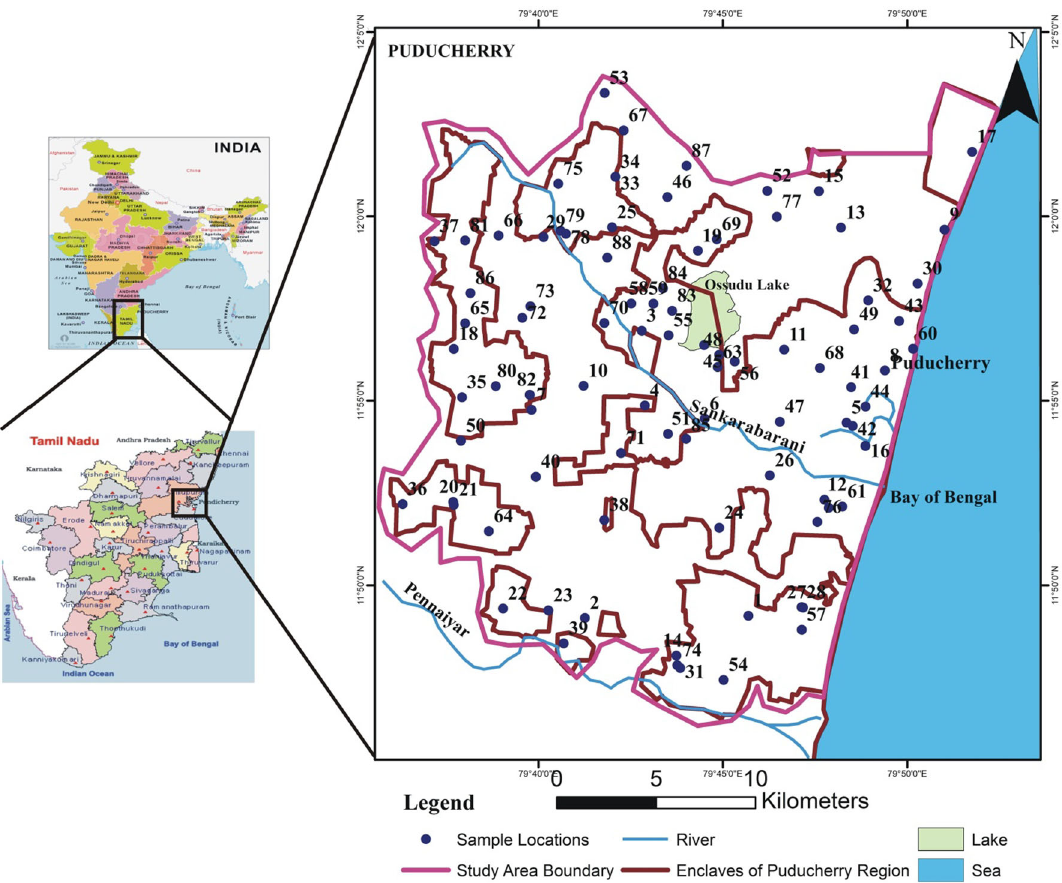
Fig. 1 Study area map with sample